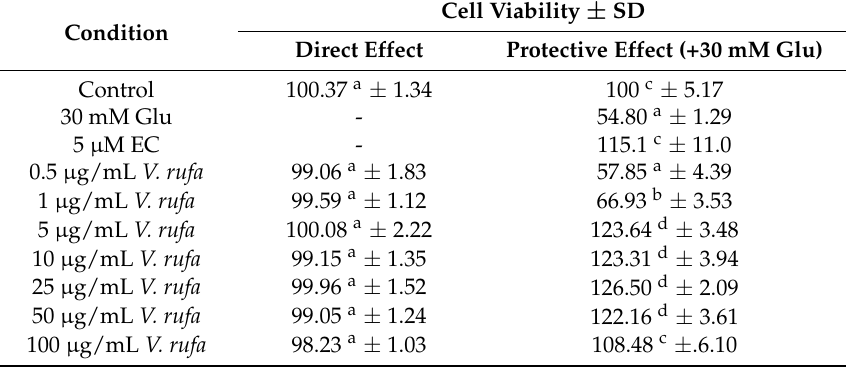
Table 1. Direct and protective effect of Vochysia rufa treatment on EA.hy926 cell viability. Cell viability was evaluated in EA.hy926 cells treated for 24 h with noted concentrations of Vochysia rufa (Vr) extract (direct effect). To assay the protective effect cells were treated for 24 h with 30 mM glucose (30 mM Glu) or 30 mM glucose plus noted concentrations Vochysia rufa (Vr) extract or the positive control epicatechin (5 µ M EC). Values are means ± SD. n = 8 (cell viability). Values are expressed as a percent relative to control condition. Different letters in each column indicate statistically significant differences ( p < 0.05) among groups.